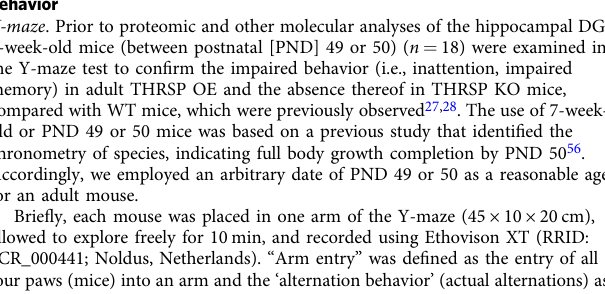
EXPERIMENT 1: Evaluation of potential genetic targets affecting ADHD-PI behavior Y-maze . Prior to proteomic and other molecular analyses of the hippocampal DG, 7-week-old mice (between postnatal [PND] 49 or 50) ( n = 18) were examined in